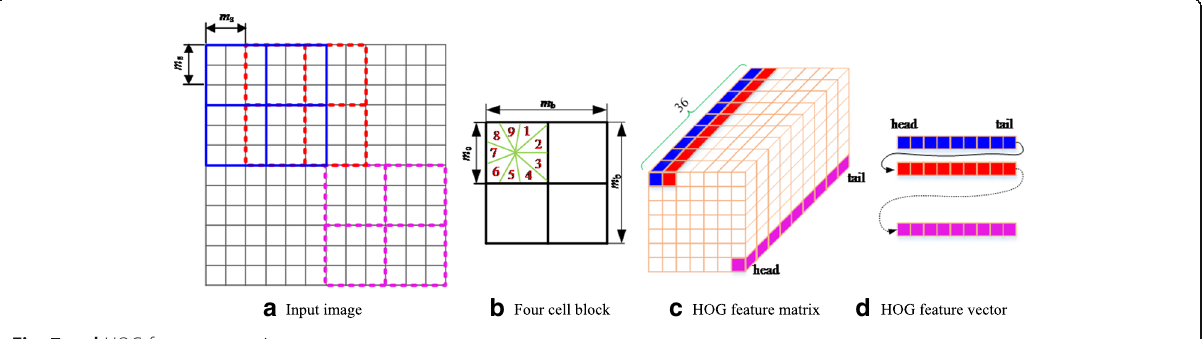
Fig. 7 a – d HOG feature extraction